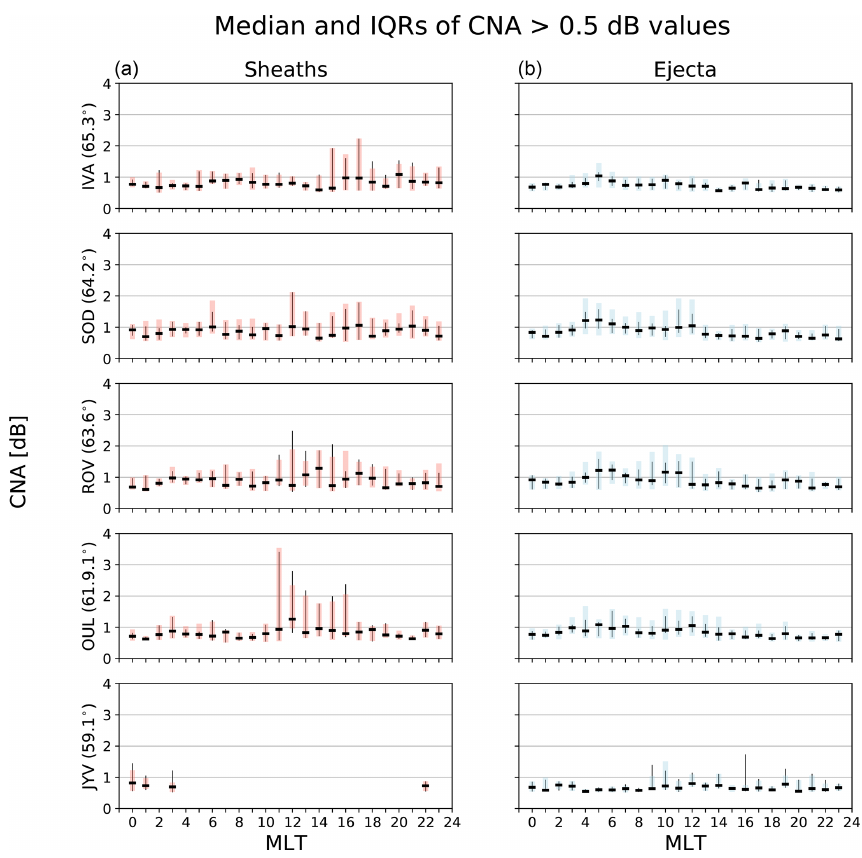
Figure 8. The medians (thick black horizontal bars) and interquartile ranges (IQRs; coloured boxes) of the CNA magnitude as a function of MLT for (a) sheaths and (b) ejecta. Only the cases with more than five samples exceeding 0.5dB during a 1h MLT bin are plotted. Stations are organized according to their MLAT ( ◦ N) that is indicated in the parenthesis for each station. Vertical lines give the bootstrap errors calculated using 10000